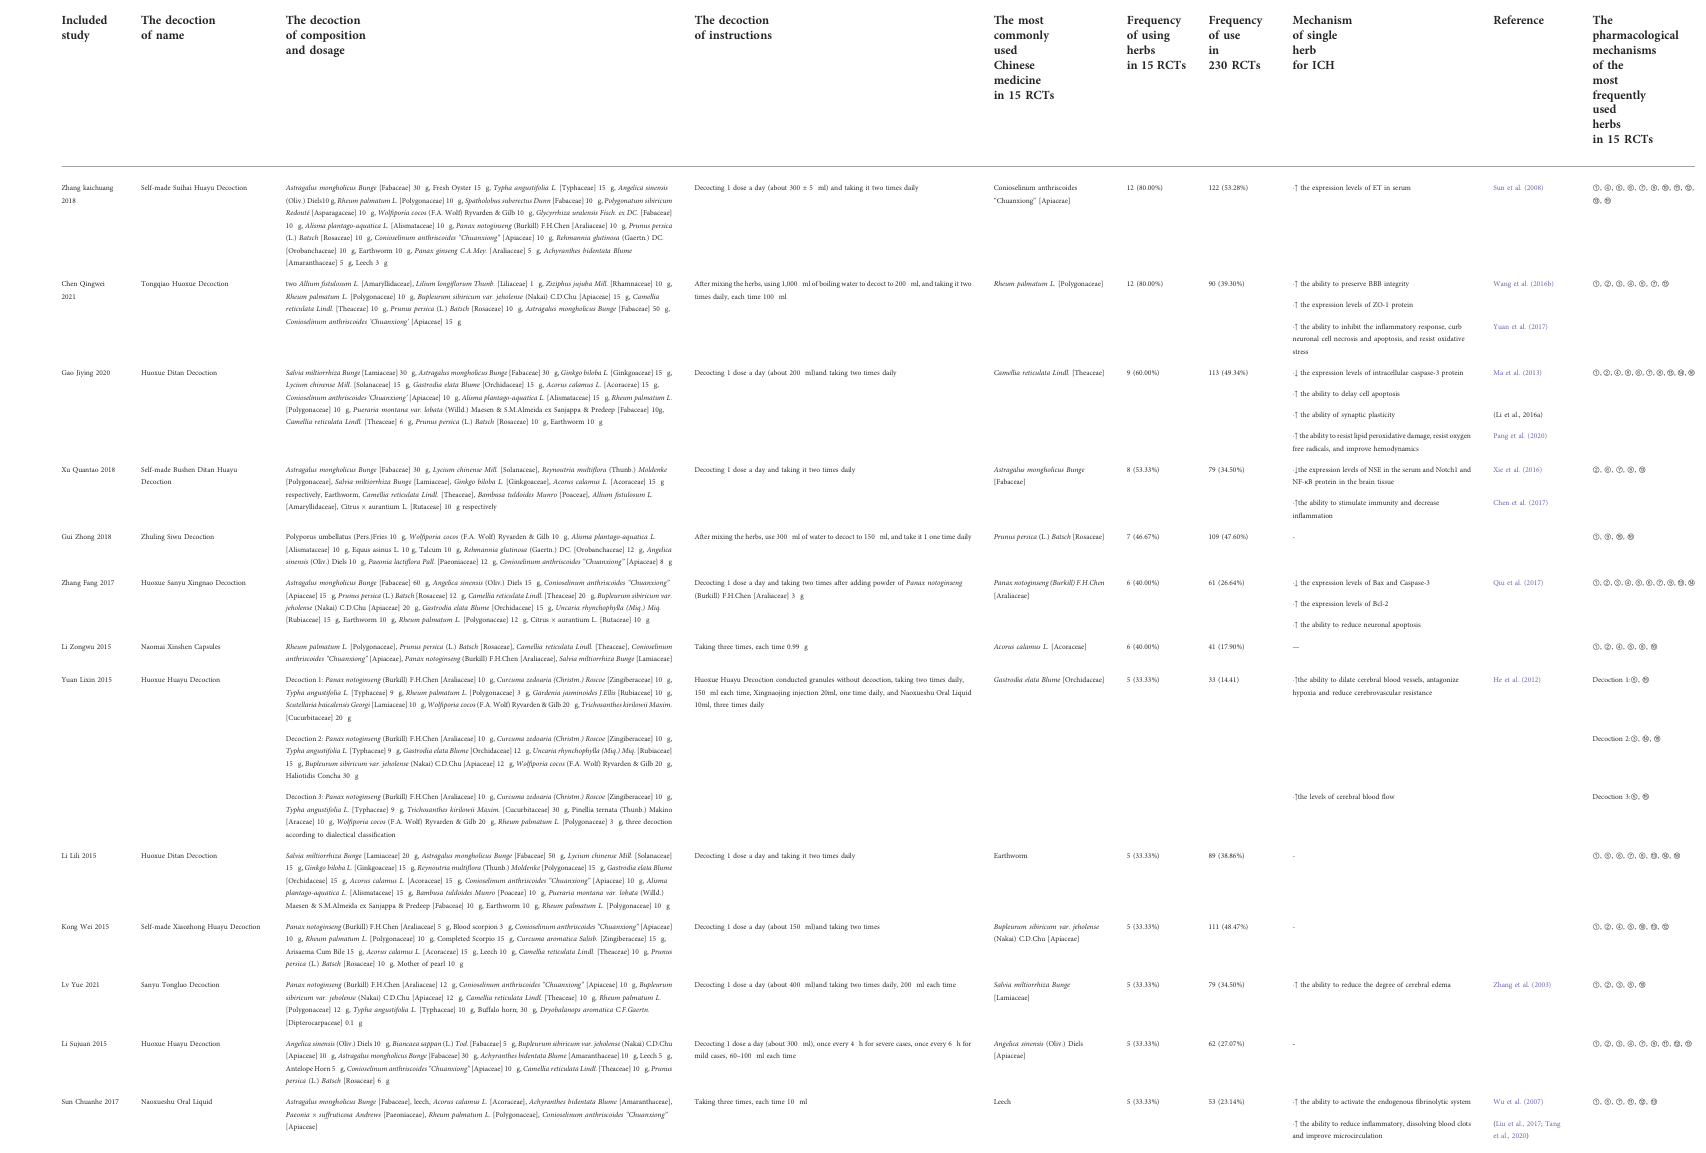
TABLE 2 Among 15 included trials, the dosage of 15 BACH in treatment of ICH and pharmacological mechanisms of these Chinese herbs. Included